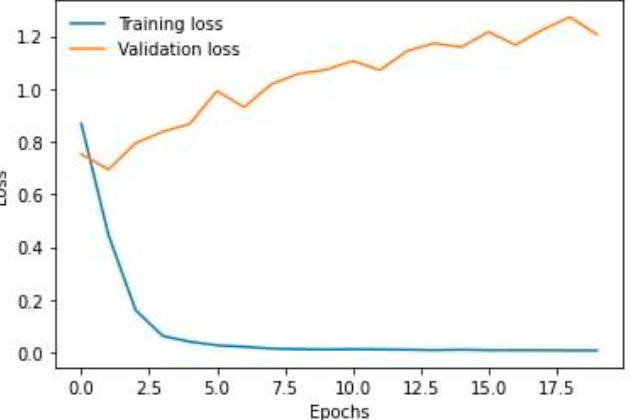
Figure 12. The Logistic Loss curve for the multi-classification model based on DeiT.